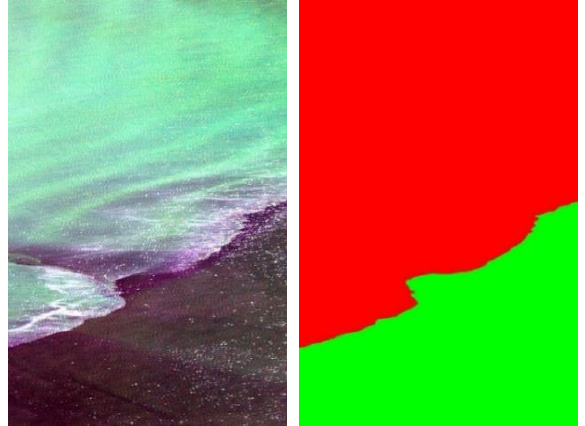
Figure 1 the map of PHI spectral remote sensing image (R:10, G:60, B:100) and the red tide validation map (red: red tide, green: seawater)